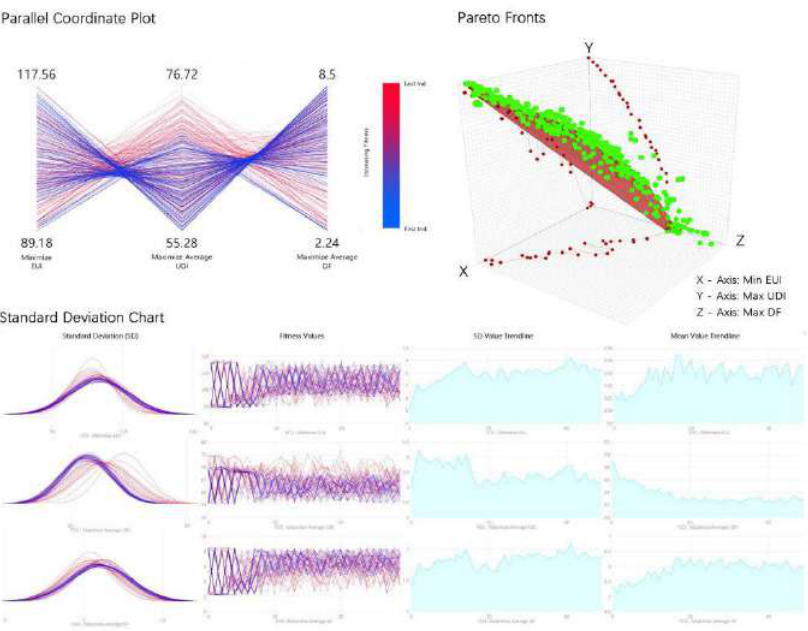
Figure 8. Parallel coordinate plot, Pareto Fronts output, standard deviation, and trendline of each index in small, east-oriented classrooms.